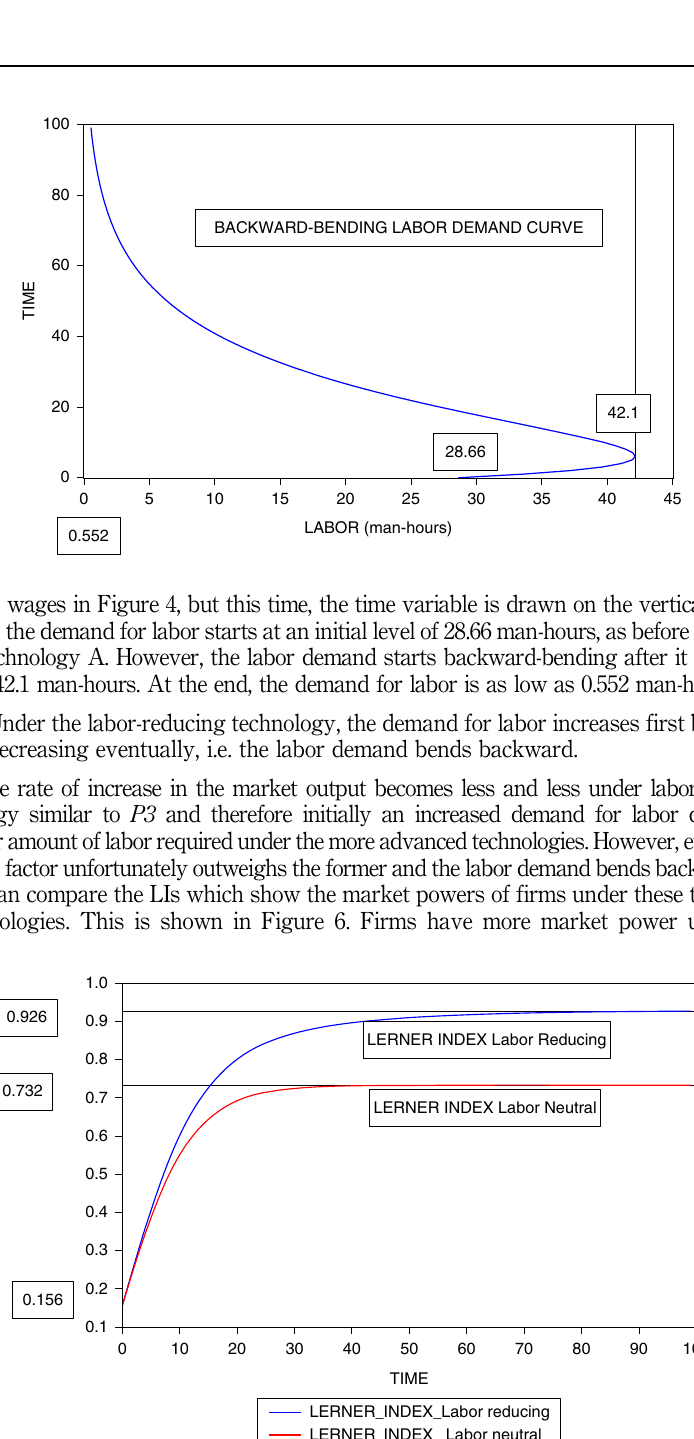
Figure 6. The Lerner indexes under labor-neutral and labor-reducing